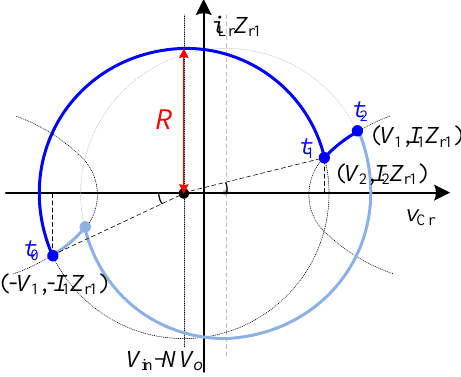
Figure 14. The state-trajectory of LLC resonant converter below resonant frequency in the ideal case.